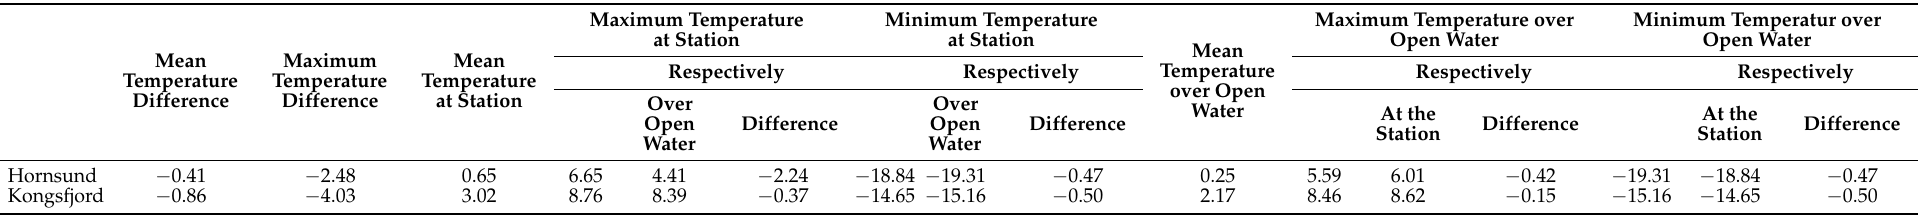
Table 1. Maximum, minimum and average temperature values over land and open water (and their differences) when a land-sea breeze type circulation is noticed and air temperature is lower over the